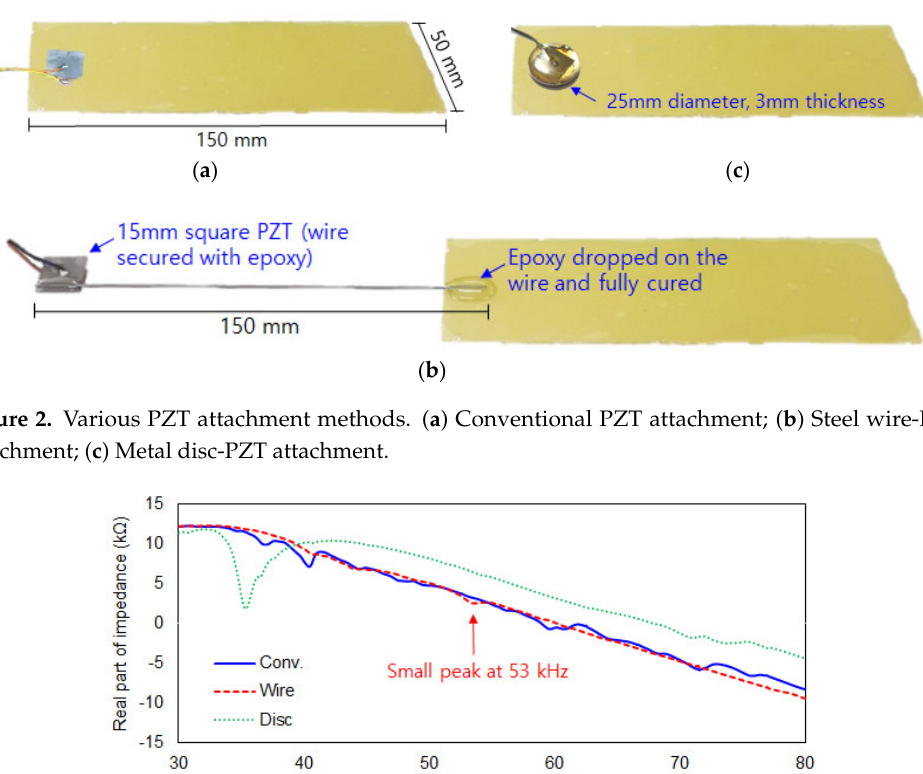
Figure 3. Reference impedance signatures for the three different PZT attachment methods.